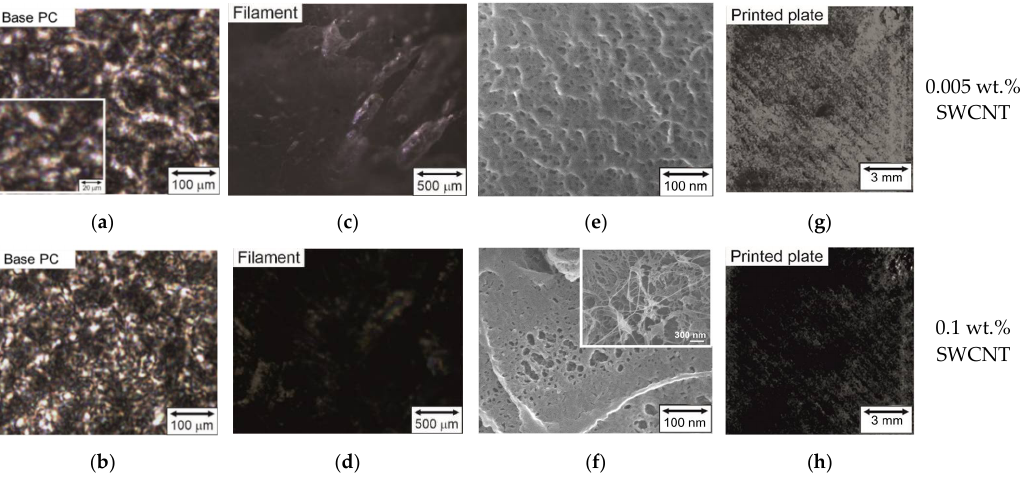
Figure 3. Microscopic study of PCs containing 0.005 wt.% SWCNTs (top images) and 0.1 wt.% SWCNTs (bottom images): optical images of base PC films ( a , b ), cross-sections of filaments ( c , d ), SEM images of filament cross-sections ( e , f ), and optical images of 3D printed plates ( g , h ). Inset in ( f ) shows SEM image of filament with 0.1 wt.% of SWCNTs from a region with poor SWCNT dis- persion.